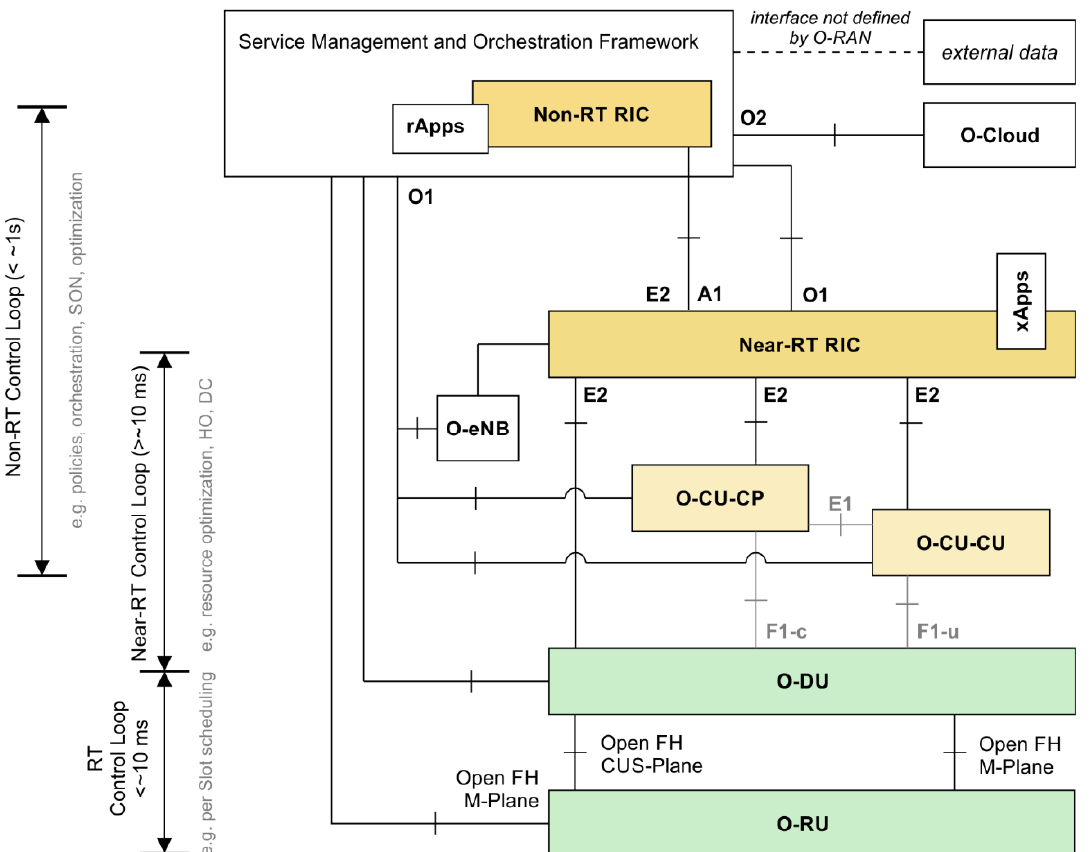
Figure 5. O-RAN reference architecture (adapted from